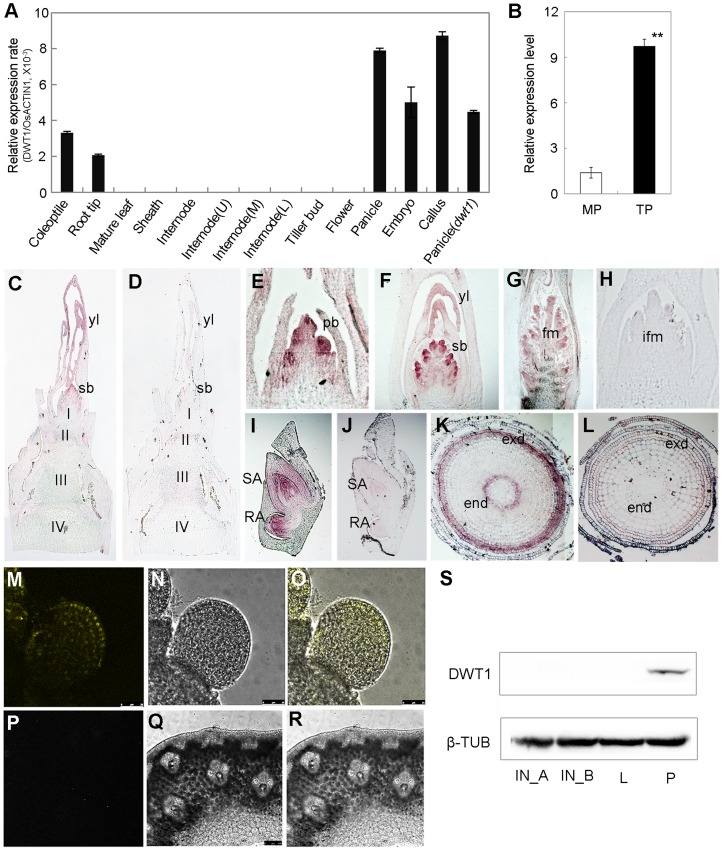
Expression pattern of DWT1 transcripts and proteins.A. qRT-PCR analysis of DWT1 gene expression levels in the wild-type tissues including coleoptiles (36 h after seed germination), root tips, mature leaf and sheath, the second internode during elongating (1 cm in length), segments of the upper (U), middle (M), and lower (L) parts of the second internode with 3 cm in length, dormant tiller bud, panicle (less than 1 cm in length), spikelet at stage Sp8 during development of pistil [63], young embryo (10 days after fertilization), and callus with 20–days regeneration. Rice ACTIN1 (OsACTIN1) was used as a control. Error bars indicate SD. n = 3. B. qRT-PCR analysis of DWT1 gene expression levels in young panicle of wild type. This experiment was biologically repeated three times, and 30 young panicles of the main shoot (MP, Length = 5 mm), and the tiller (TP, Length = 5 mm) respectively were used in each test. Error bars indicate SD, and the significant differences from panicle of main shoot are marked (**p<0.01, Student's t test). C–L. In situ hybridization of DWT1. Signals were detected in the primary branch meristem (E), secondary branch meristem (C, F), top portion of the panicle (G), shoot apical and radical apical of young embryo (I), and endodermis and exodermis of root tip (K). D, H, J and L were corresponding sections hybridized with the sense probe.I,II,III,IV, the first, second, third and the forth internode, respectively; pb, primary branch meristem; sb, secondary branch meristem; yl, young leave; fm, floral meristem; ifm, inflorescence meristem; exd, exodermis layer; end, endodermis layer. M–R. YFP fluorescence image of the branch meristem (M–O) and the internode (P–R) in transgenic plants expressing pDWT1:DWT1-YFP. M and P are fluorescence image, N and Q are light view, O and R are overlapping of fluorescence image and light view. S. Western-blot analysis of DWT1 protein levels. DWT1 protein was analyzed by immunoblotting using an anti-DWT1 antibody using mature flag leaf (L, 3 leaves from 3 different plants), elongating internodes (IN_A, length = 0.5 cm; IN_B, length = 3 cm, 10 internodes from different plants) and young panicle (P, length less than 2 mm, 50 panicles from different plants). β-tubulin was used as a control. These experiments were biologically repeated three times.